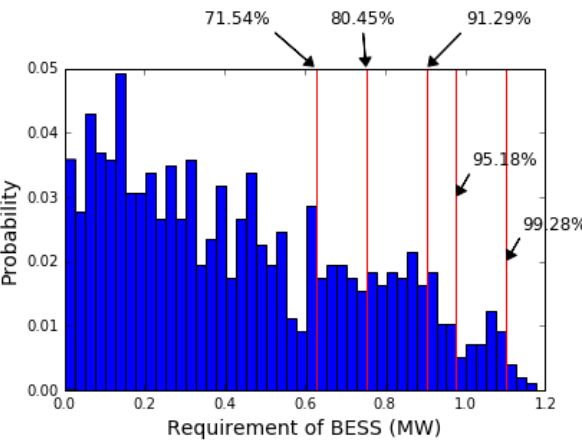
Table 10. The comparison of capacity requirement.